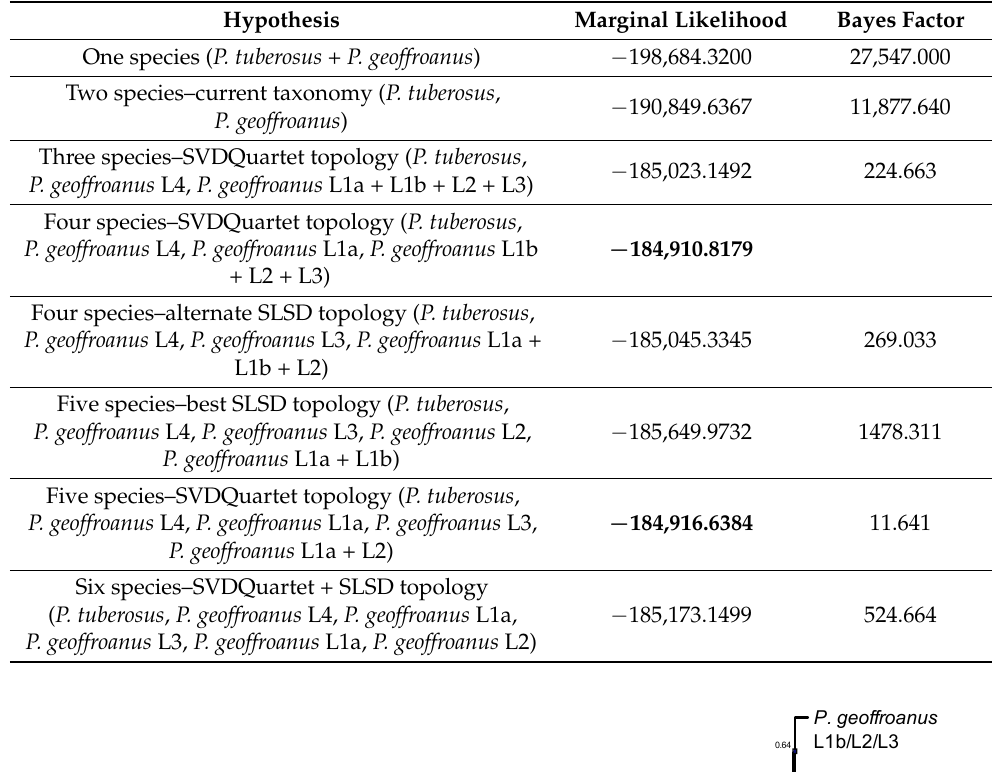
Table 2. Test of taxonomic hypotheses using path sampling in BEAST2. Differences in marginal likelihoods were evaluated using Bayes factors. The four species hypothesis ( P. tuberosus , P. geoffroanus